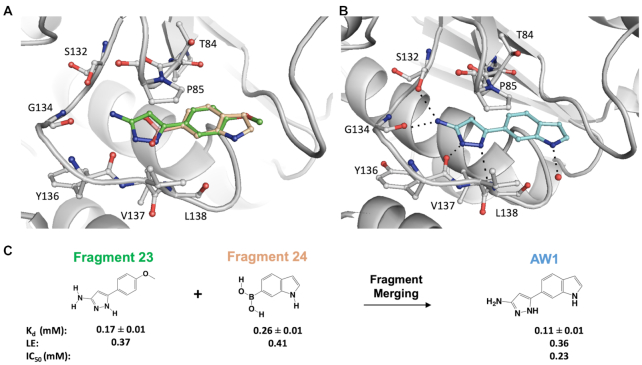
Fragment merging approach. (A) Structural superposition of TrmD (gray) in complex with fragments 23 (green) and 24 (beige) – PDB Codes 6QOT and 6QOU, showing binding mode and interactions at the SAM site (B) merged compound AW1 (light blue), PDB Code 6QQS, showing binding mode at the SAM site. The corresponding amino acid interactions are illustrated in dotted lines and (C) the overall scheme of fragment merging.